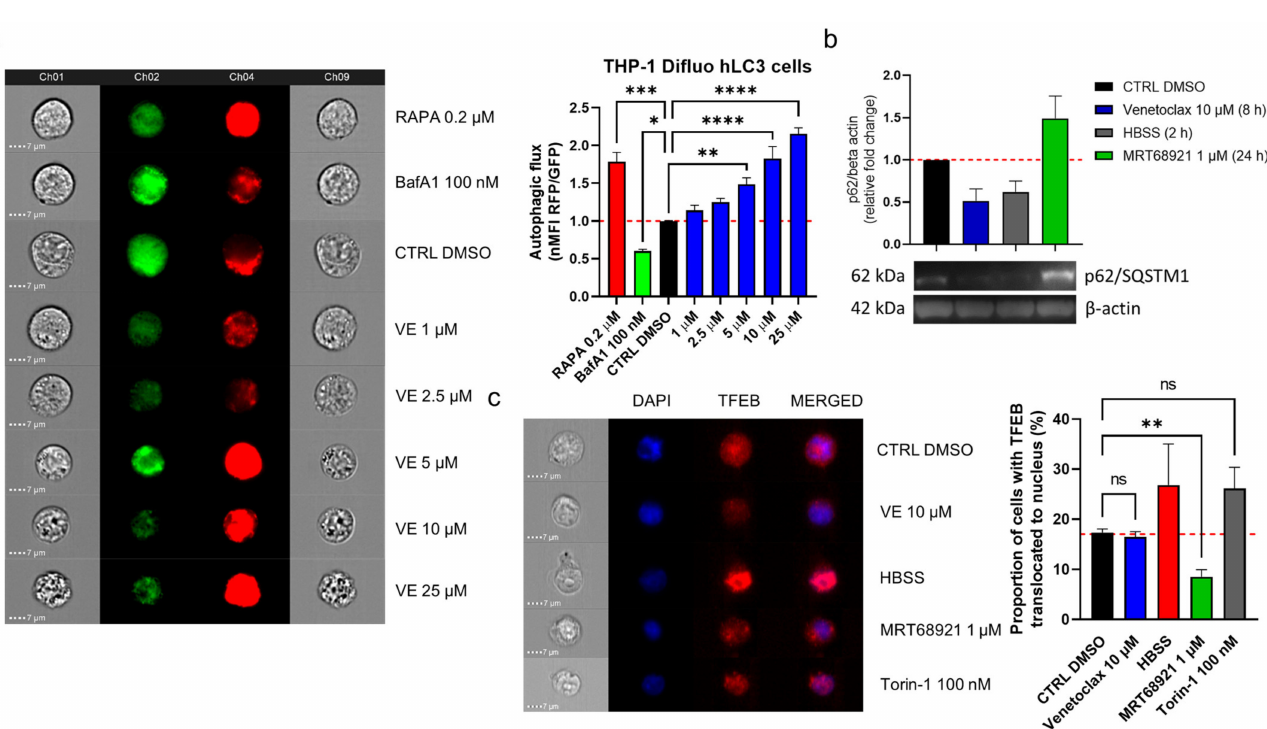
Figure 6. Venetoclax induces autophagy in CLL cells. ( a ) THP1-Difluo hLC3 cells (5 × 10 5 cells/mL) following the treatments with venetoclax (VE; 1–25 µ M), the autophagy inducer rapamycin (RAPA; 200 nM), and the autophagy inhibitor bafilomycin A1 (BafA1; 100 nM) for 24 h. The expression of GFP and RFP were determined by imaging flow cytometry. Data are means ± SEM of 5 independent experiments. Representative cell images for each sample are shown; ( b ) Immunoblot analysis of p62/SQSTM1 in MEC-1 cells (1 × 10 6 cells/mL) treated with vehicle control (0.2% DMSO) and 1 µ M MRT68921 for 24 h, 10 µ M venetoclax for 8 h, or HBSS for 2 h. The cells were harvested and lysed, and the proteins were separated by SDS PAGE, blotted onto nitrocellulose membranes, and probed for the expression of the autophagy marker p62/SQSTM1, with the loading control of β -actin. Data are means ± SEM of 3 independent experiments. A representative immunoblot is also shown; ( c ) Representative cell images (left) and quantification (right) of TFEB translocation in MEC-1 cells. The cells (5 × 10 5 cells/mL) were treated with the vehicle control (0.2% DMSO) or to 10 µ M venetoclax, HBSS, 1 µ M MRT68921 or 100 nM Torin-1, for 1 h. After, the cells were fixed and permeabilized, and stained with an anti-TFEB antibody and the nuclear stain DAPI. Nuclear translocation of TFEB was monitored using imaging flow cytometry. Data are means ± SEM of ≥ 3 independent experiments. One-way ANOVA with Dunnett’s multiple comparisons test was used. Not significant (ns), ∗ , ∗∗ , ∗∗∗ , and ∗∗∗∗ denote p > 0.05, p < 0.05, p < 0.01, p < 0.001, and p < 0.0001